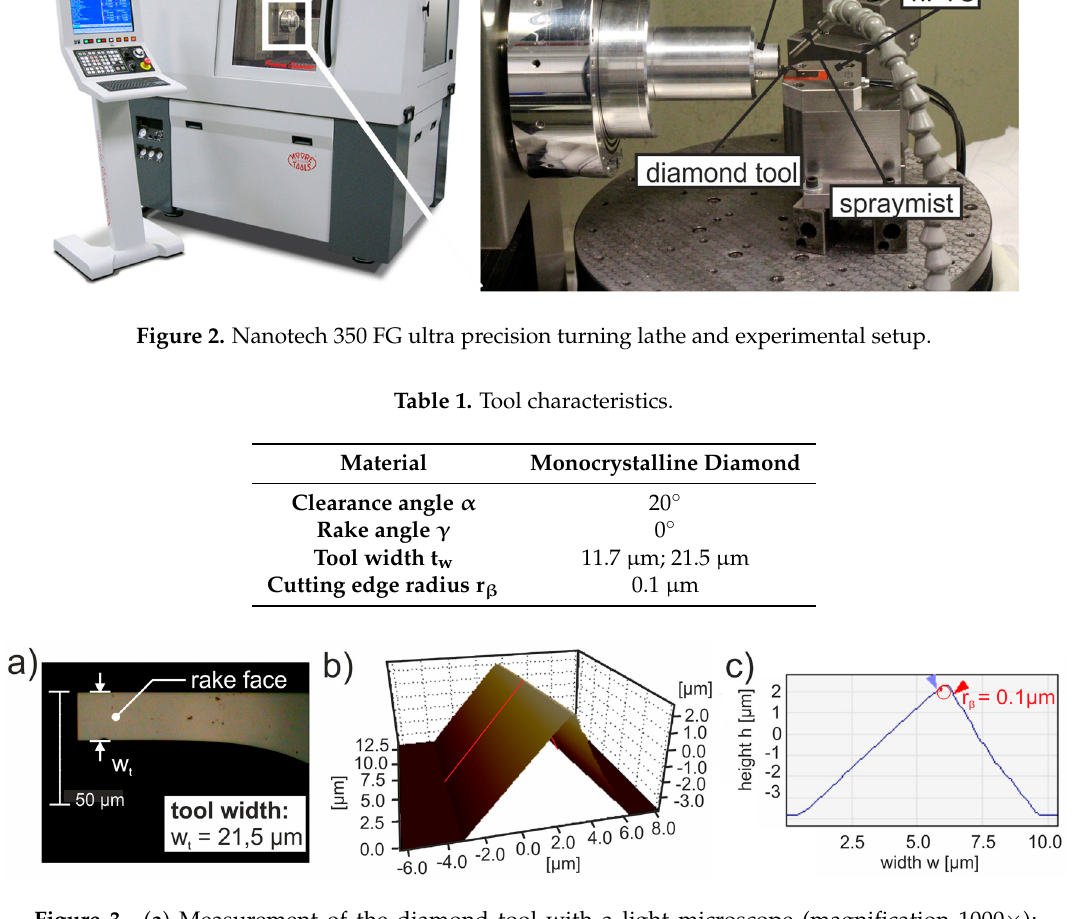
Figure 3. ( a ) Measurement of the diamond tool with a light microscope (magnification 1000×); ( b ) measurement of the tool tip with an atomic force microscope; ( c ) cross section of the tool tip measurement with evaluation of the cutting edge radius. Table 2. Mechanical properties of the investigated materials. Table 2. Mechanical properties of the investigated